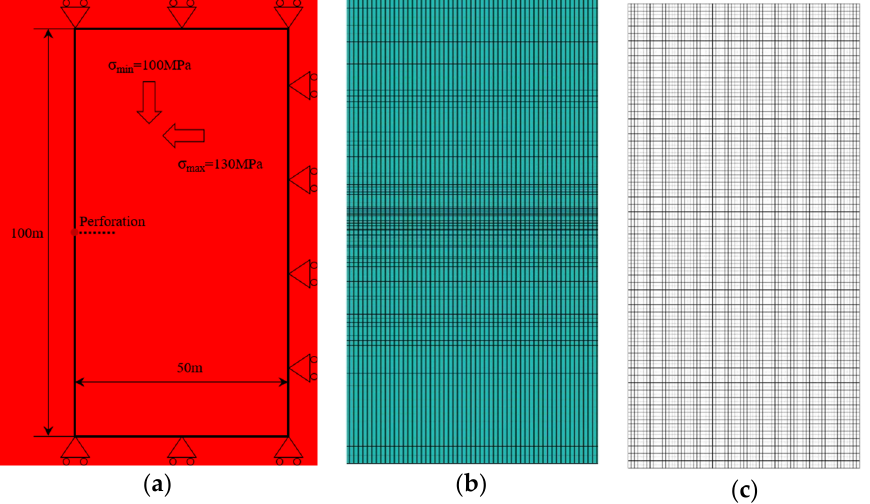
Figure 6. Schematic of the numerical model. ( a ) Geometry; ( b ) grids used for FEM–ABAQUS; and ( c ) grids used for proposed EDFM–XFEM model.